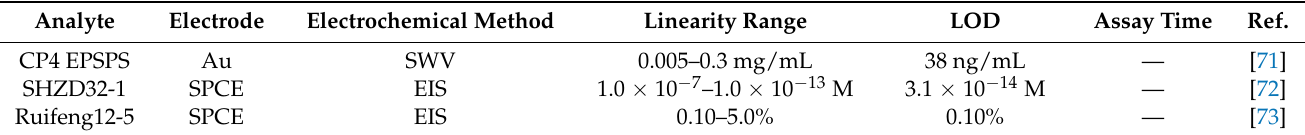
Table 8. Electrochemical biosensors for the detection of